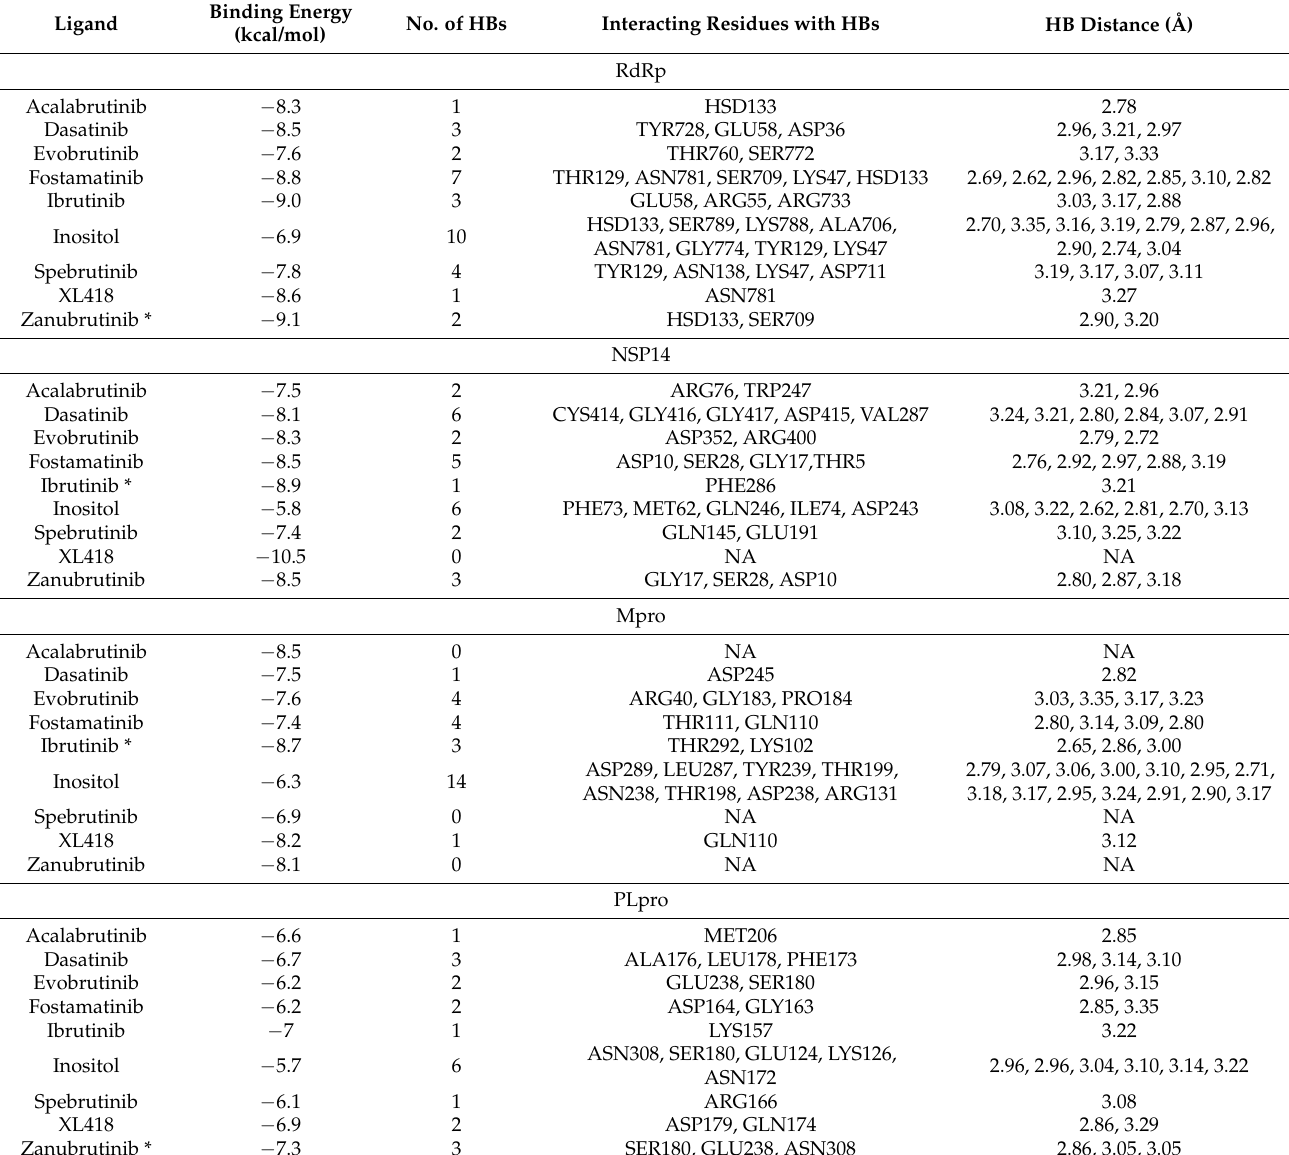
Table 3. Molecular binding interactions of the selected drugs with nonstructural proteins (RdRp, Nsp14, Mpro and PLpro) of